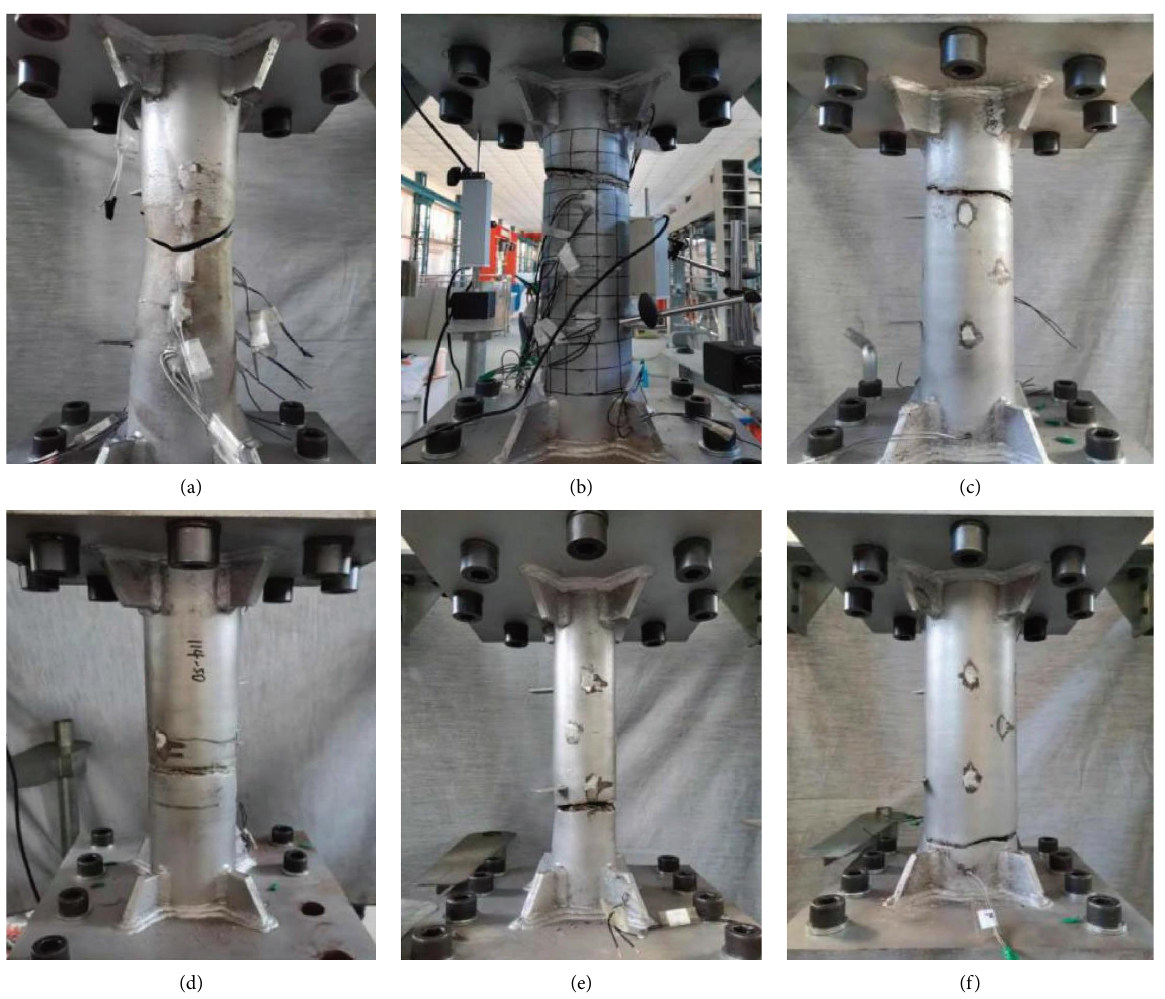
Figure 9: Damage of specimens: (a) 114-0, (b) 114-40, (c) 114-30, (d) 114-50, (e) 89-40, and (f) 139-40.